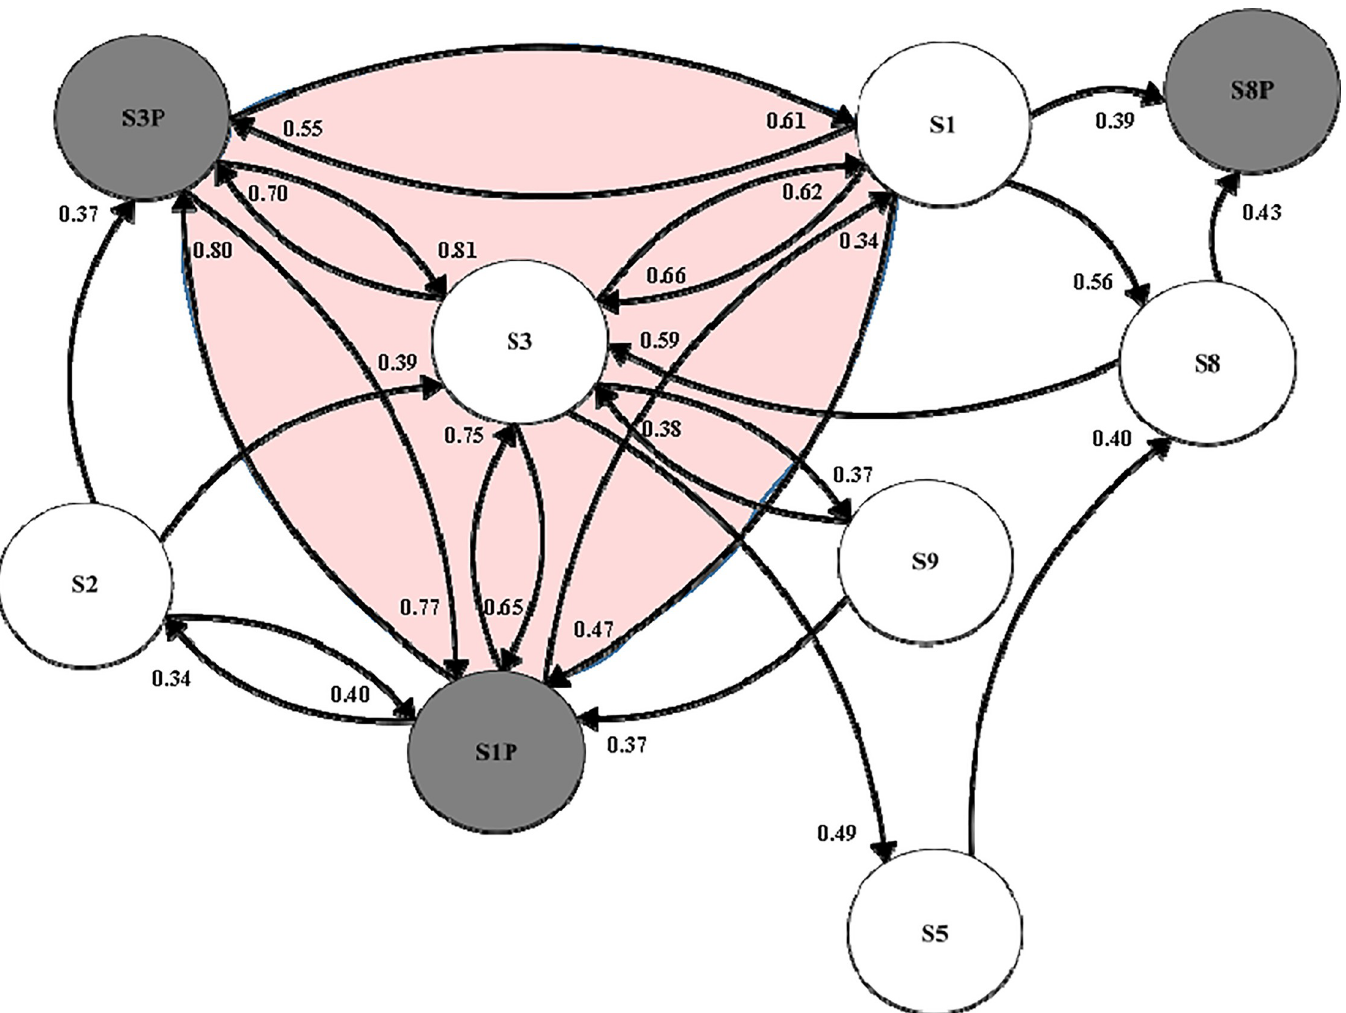
Fig 10. Community interaction diagram. We summarize causal interactions detected with CCM in a community interaction diagram whose nodes are sales and promotions signals screened for stationarity and nonlinear deterministic dynamic behavior. Arrows between nodes indicate the direction of interaction. The strength of the interaction is given by the fractions near each arrow head, which are the convergent correlation coefficients for each cross mapping. We focus on the area of the diagram (shaded red) containing bilateral interactions between ABInbev brand configurations Leffe Blonde Lager Bottles 4X330 1320ml and Hoegaarden White Lager Bottles 4X330 1320ml; and between these ABInbev configurations and the Innis & Gunn Original Oak Aged Beer 750ml configuration, which is not owned by